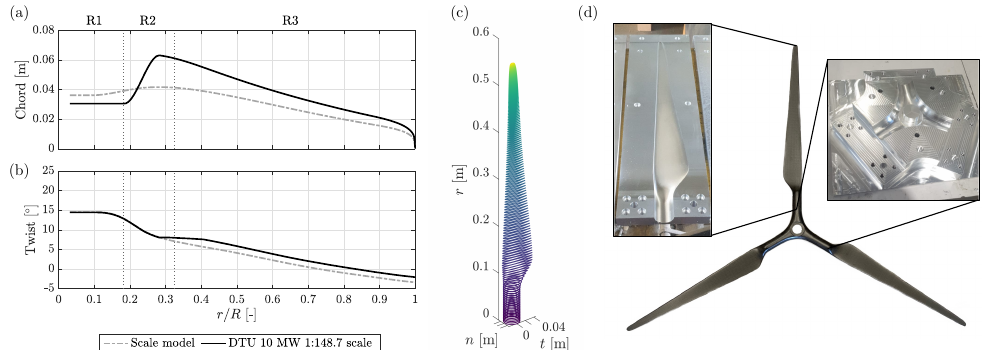
Figure 4. Geometry of the scale model blade and rotor. ( a , b ) Chord and twist of the scale model blade are compared to the DTU 10 MW at 1:148.7 scale. ( c ) Geometry of the blade at 174 radial sections. ( d ) Picture of the rotor and of the mold